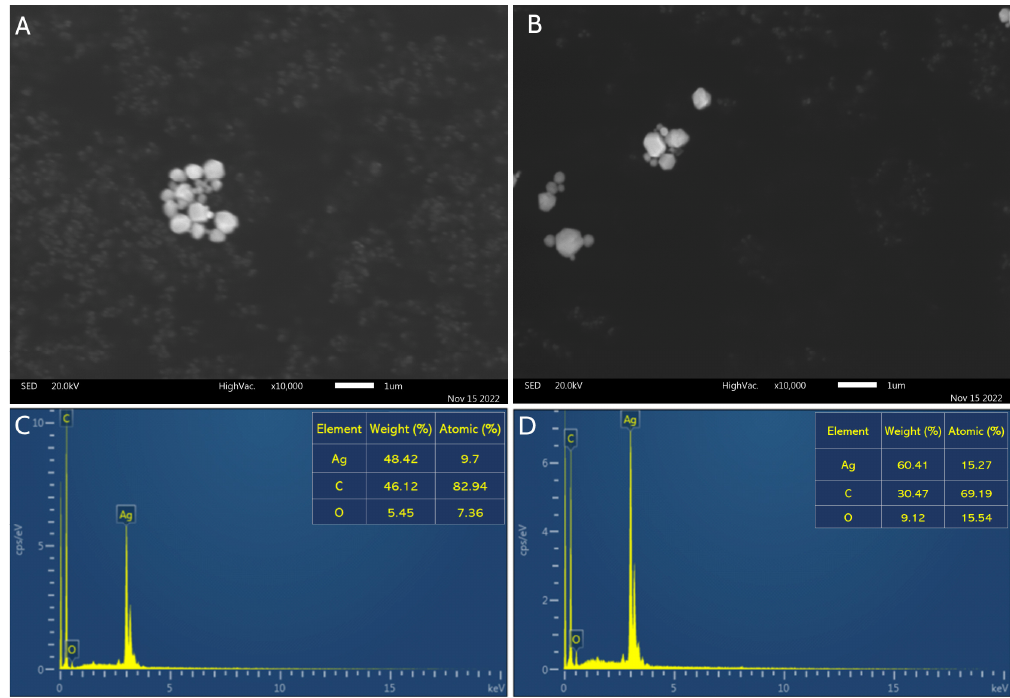
Figure 5. SEM image of synthesized SVAgNP ( A ) and FUAgNP ( B ) with corresponding EDX spectra (( C ) and ( D ), respectively).